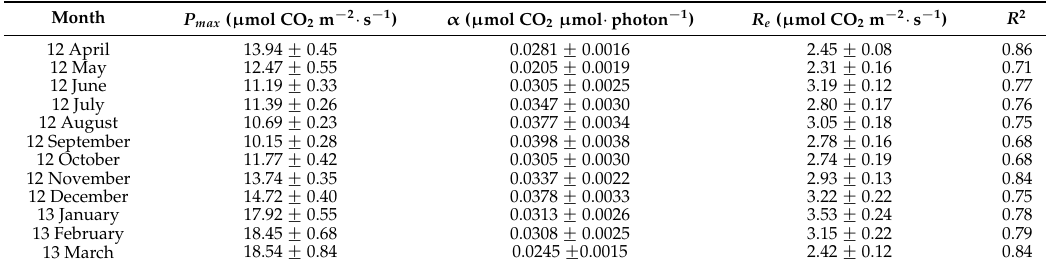
Table 2. Monthly estimates of ecosystem photosynthesis parameters with standard error (95% confidence).